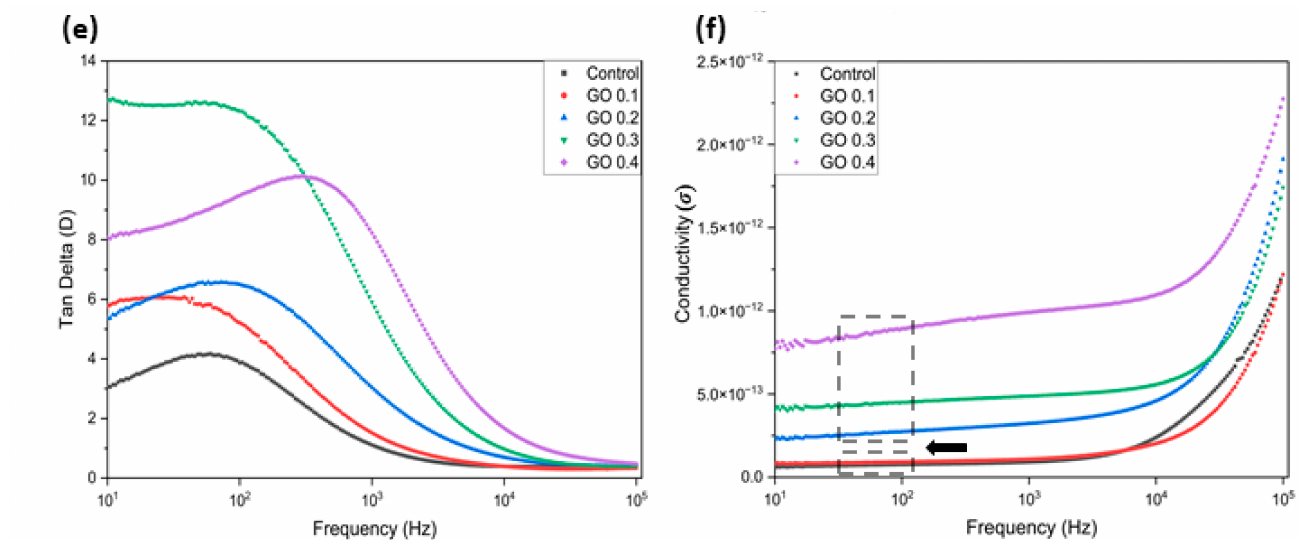
Figure 2. Influence of GO on different electrical parameters of geopolymer composites: ( a ) capacitance, ( b ) impedance, ( c ) dielectric constant, ( d ) dielectric loss, ( e ) tan delta and ( f )